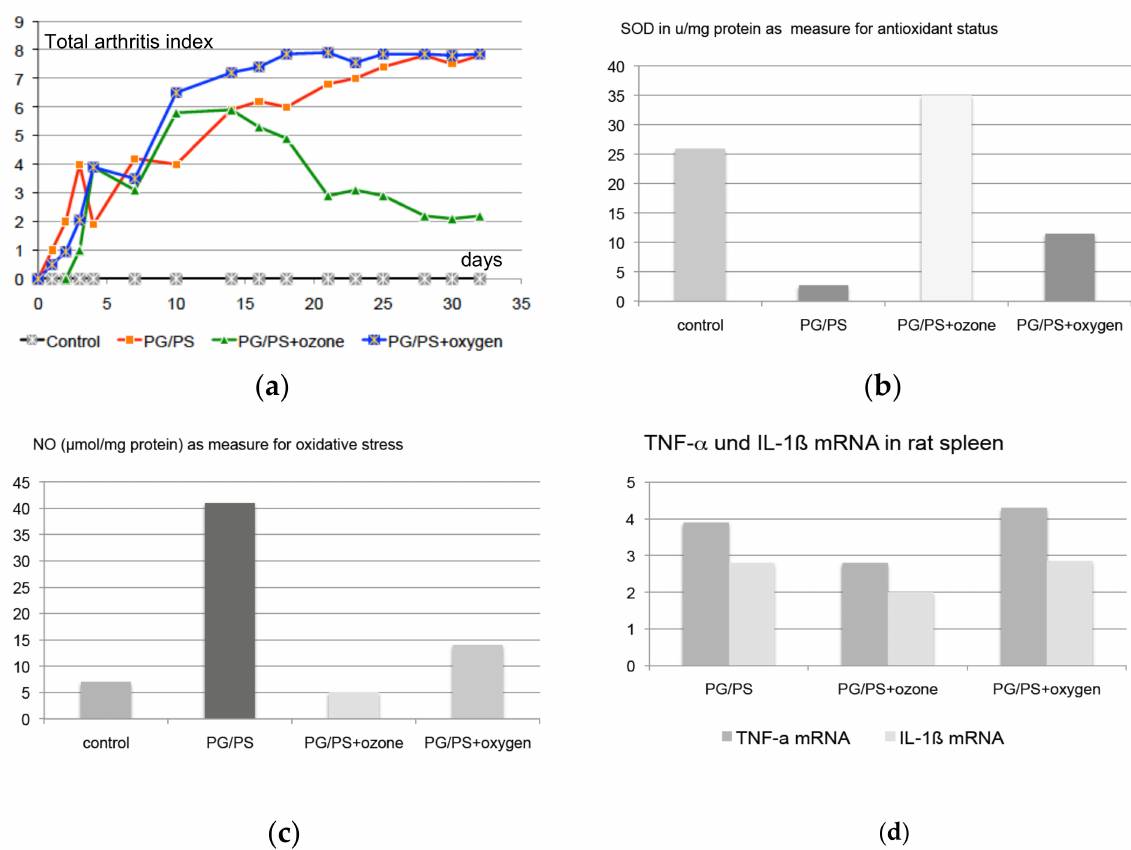
Figure 9. ( a ) Development of the total arthritis index (joint swelling) over 35 days in a preclinical study ( n = 20) on rheumatoid arthritis RA in rats under intraarticular ozone treatment 3 × per week, 20 µ g/mL, 0.2 mL, starting on day 10. Control ( n = 5): intraarticular needle stress 3 × per week. PG/PS-induced rheumatoid arthritis ( n = 15) (peptidoglycan/polysaccharide). PG/PS + ozone ( n = 5): ozone treatment starting on day 10. PG/PS + oxygen ( n = 5): oxygen (0.2 mL) treatment starting at day 10 [25]. ( b ) The antioxidant capacity, here as superoxide dismutase SOD in the spleen of RA-rats after 10 intraarticular ozone treatments compared to oxygen treatment and control as described in Figure 9a [25]. ( c ) Oxidative stress, measured as NO in the rat spleen following 10 intraarticular ozone treatments compared to oxygen and control as described in Figure 9a [25]. ( d ) Downregulation of inflammatory stress parameters TNF- α mRNA and IL-1 β mRNA, measured in arbitrary units in the rat spleen following 10 intraarticular ozone treatments compared to oxygen as described in Figure 9a